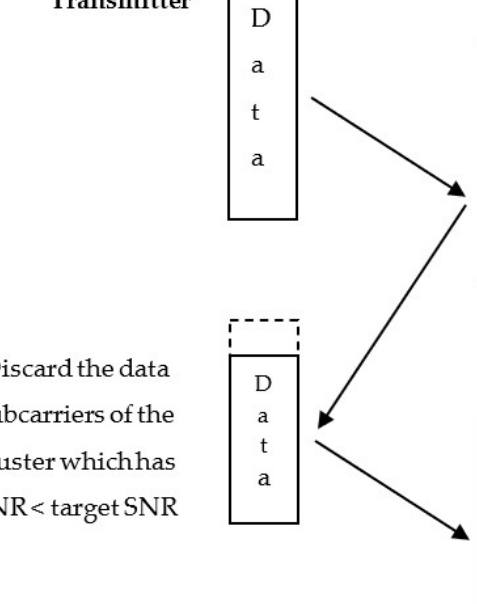
Figure 4. Discarding data subcarriers depending on the cluster SNR estimation.